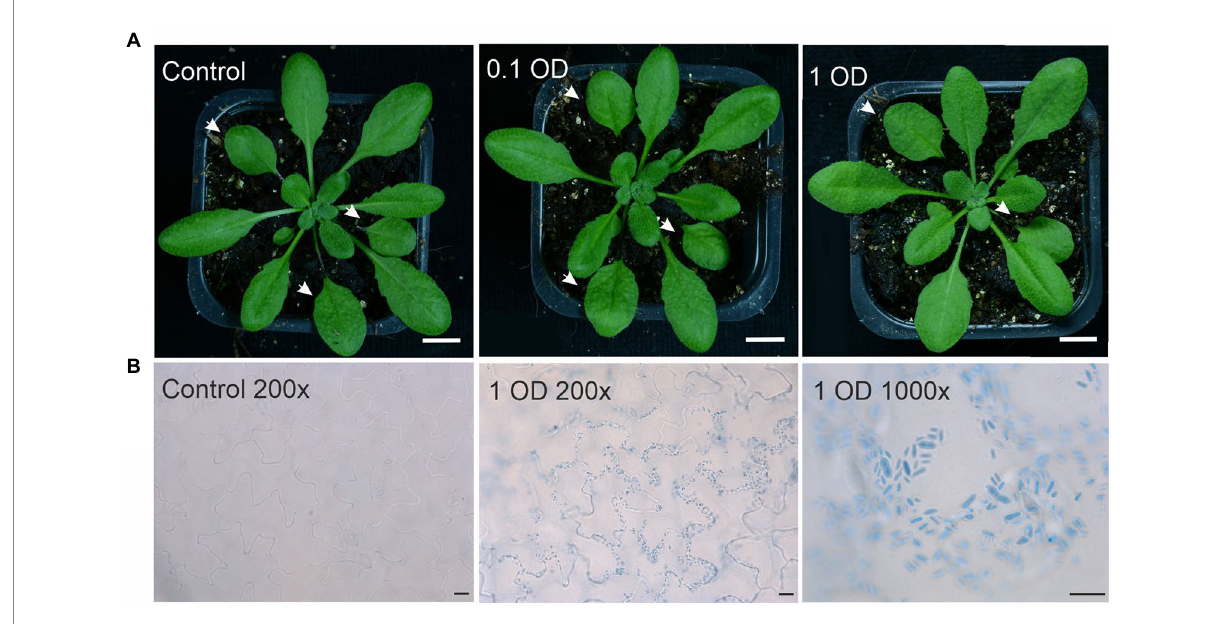
FIGURE 1 Arabidopsis leaves infected with Protomyces arabidopsidicola . (A) Arabidopsis (Col-0 accession) plants either mock treated with 10 mM MgCl 2 (control) or drop infected in the middle of the left hand leaf half with a 0.1 OD or a 1 OD suspension of P. arabidopsidicola cells in 10 mM MgCl 2 and photographed at ten days post infection. Treated leaves are indicated with white arrows. White scale bars in all photos are 1.0 cm. (B) Photomicrograph of Arabidopsis leaves either mock treated with 10 mM MgCl 2 (control 200×) in the right panel or infected with a 1 OD suspension of P. arabidopsidicola cells (1 OD 200×) in the middle panel. Leaves were stained with trypan blue to visualize P. arabidopsidicola cells. The right hand panel (1 OD 1,000×) is a close up showing the typical Protomyces yeast-type cell structure of the visualized cells. Scale bars: